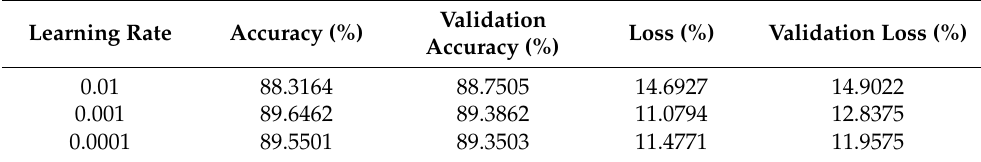
Table 3. Comparison with different learning rates of Adam optimizer and Softmax activation layer.